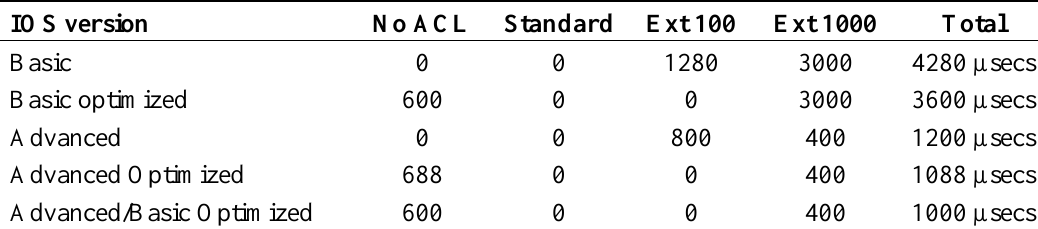
Table 4. Calculated Delays for example network route within